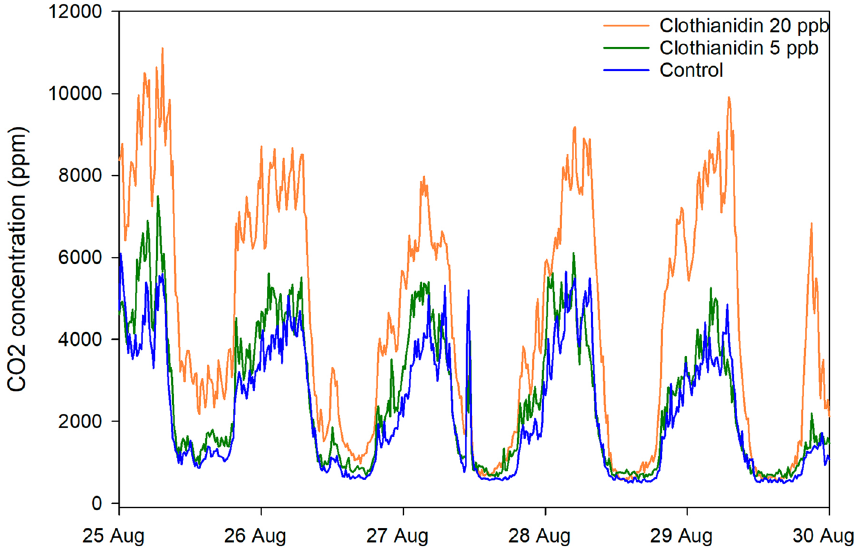
Figure 8. Average CO 2 concentrations per treatment group for 5 days immediately after the end of treatment for each of 3 groups: Clothianidin 20-ppb (orange), clothianidin 5-ppb (green), and control (blue) for the AZ 2018